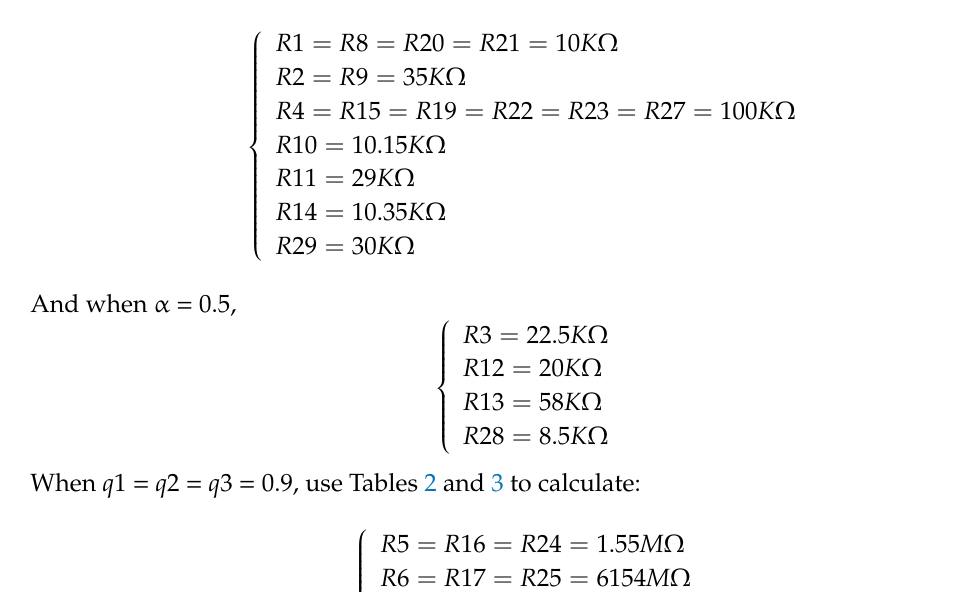
Figure 12. Fractional-order unified chaotic system circuit diagram.